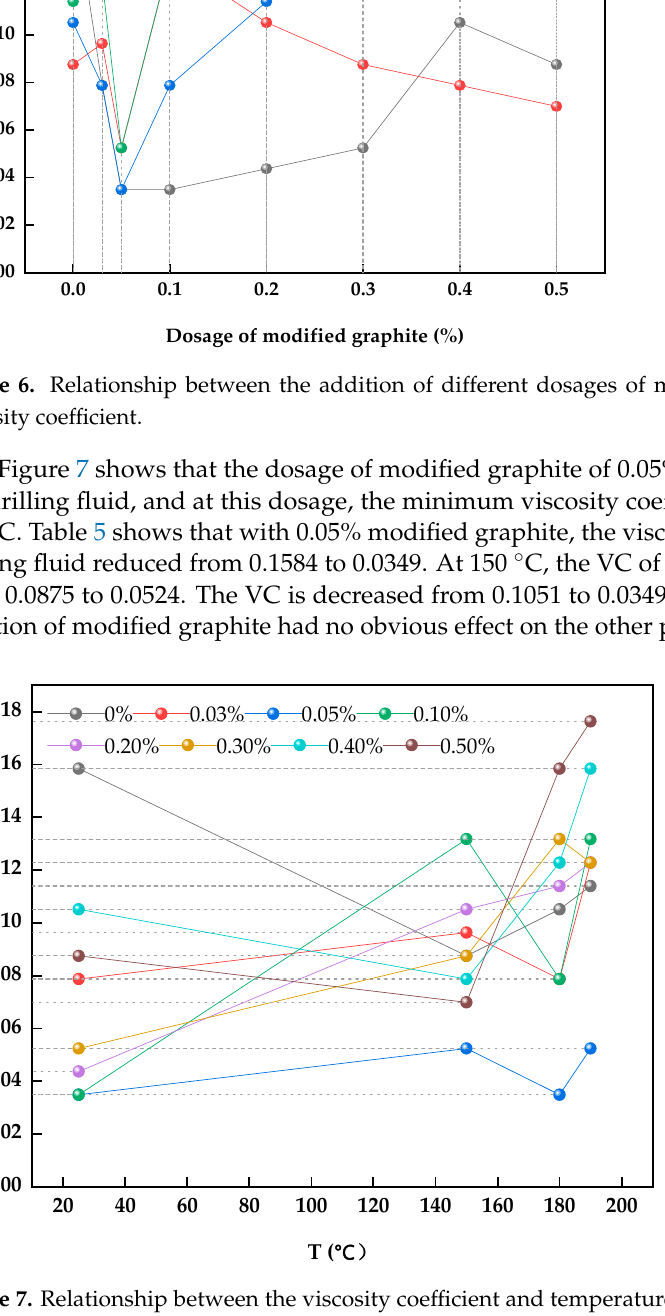
Figure 7. Relationship between the viscosity coefficient and temperature of the drilling fluid with different dosages of modified graphite.